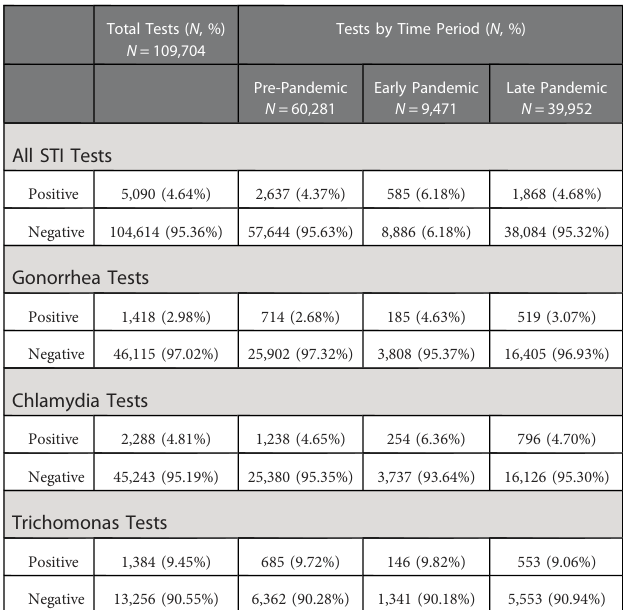
TABLE 3 Outcomes of STI testing of patients tested for gonorrhea, chlamydia, or trichomonas from November 1, 2018, through July 31, 2021, by COVID-19 time period.